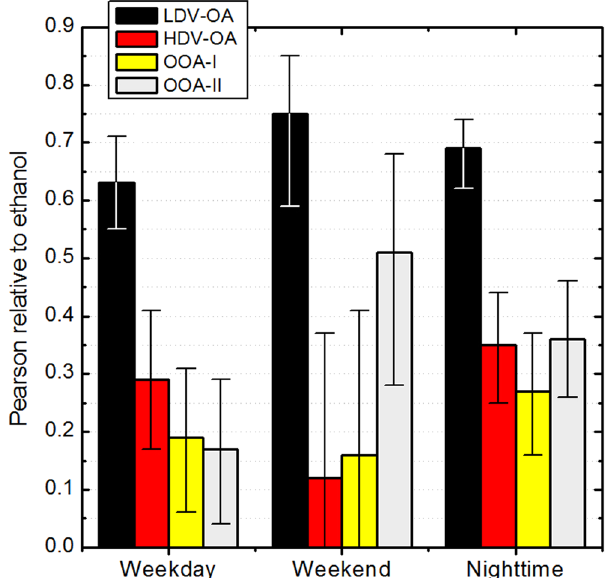
Figure 1. Linear fit Pearson correlation between ethanol and factors of organic aerosols resolved using PMF. Weekday (Monday thru Friday) and Weekend (Sunday only) refers for daytime data (06–18:00 LT) and Nighttime refers to 18:00–06:00 LT without day of the week separation. Range bars indicate confidence intervals. All fits are statistically meaningful (p < 0.005) except weekend data of HDV-OA and